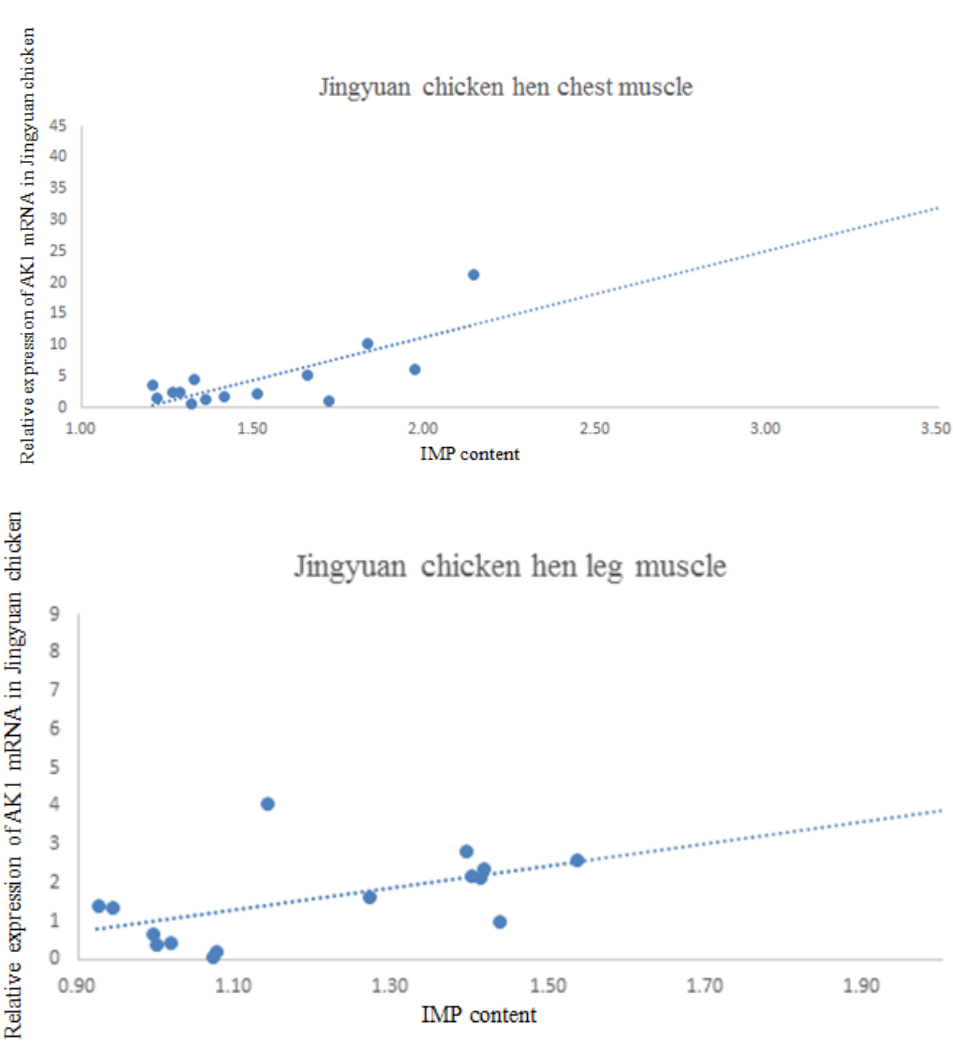
Figure 8. Jingyuan chicken AK1 mRNA and IMP content scatter plot.